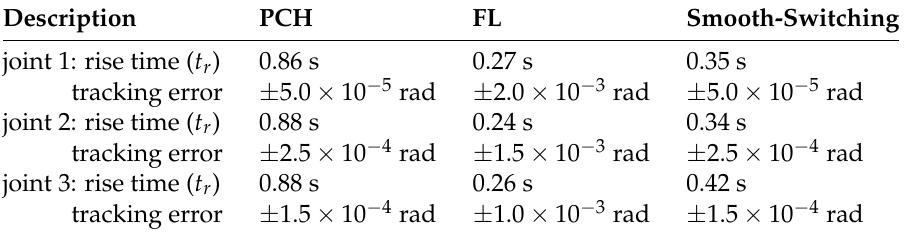
Table 1. Performance indexes of PCH, FL and smooth-switching with unit step